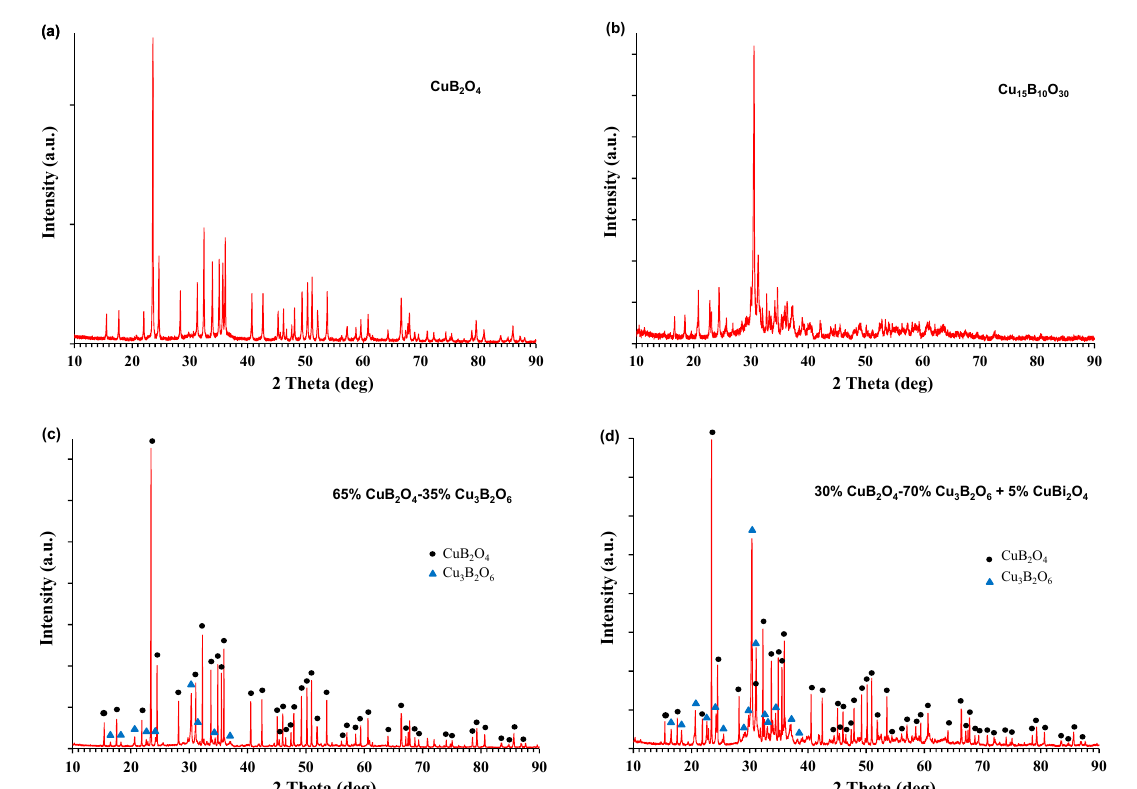
Figure 1. Diffraction patterns of the ceramics: ( a ) CuB 2 O 4 , ( b ) Cu 3 B 2 O 6 , (c) 65% CuB 2 O 4 –35% Cu 3 B 2 O 6 , and ( d ) 30% CuB 2 O 4 –70% Cu 3 B 2 O 6 doped with 5% CuBi 2 O 4 .